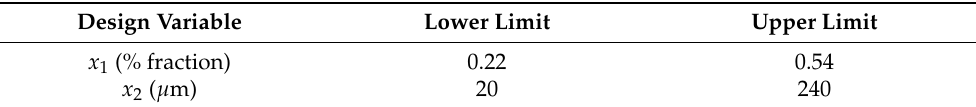
Table 2. Lower and upper bounds of the porosity and single side electrode coating thickness of the LIB